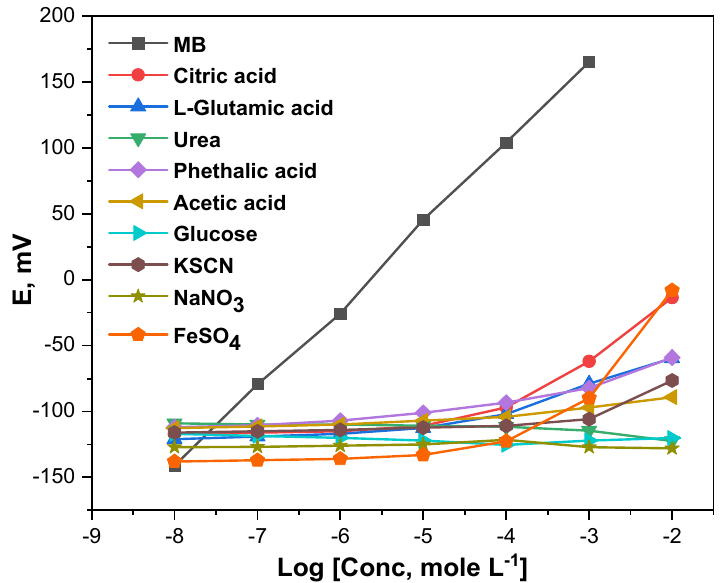
Figure 6. Potentiometric response of the MIP-based microchip toward MB and some interference species.